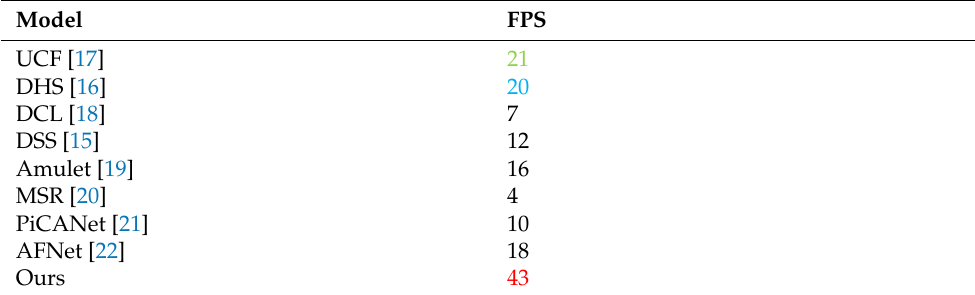
Table 3. Average speed (FPS) comparisons between our approach and the previous state-of-the-art methods. The best three results are shown in red, green and blue.